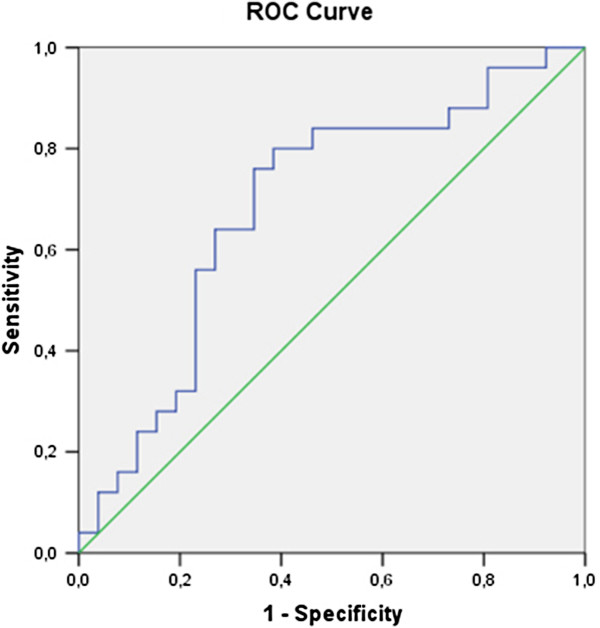
ROC analysis of resistin in patients with diabetes and inpaired glucoe tolerance.